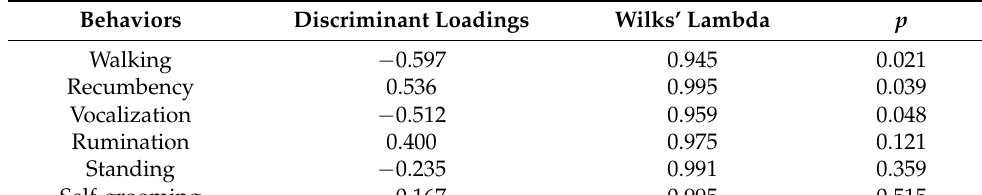
Table 2. Parameters indicating the relative importance of behaviors in classifying the camel location: